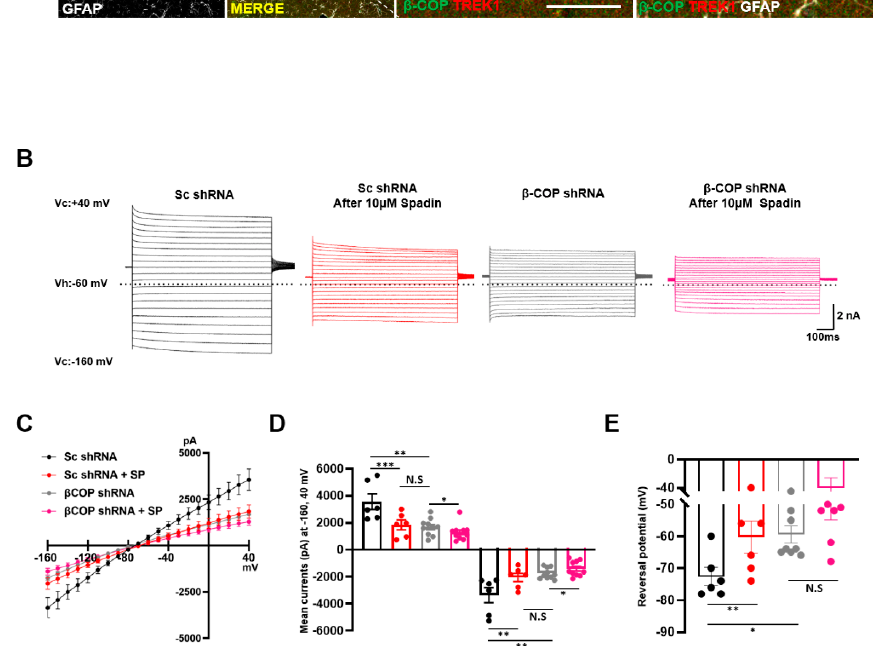
Figure 7. β -COP regulates passive conductance in hippocampal astrocytes. ( A ) Representative image of immunohistochemistry (IHC) in the hippocampus (CA1) and an enlarged image. β -COP (green) is expressed as abundantly as TREK1 (red) in GFAP-positive cells (white) of the hippocampus and colocalizes with TREK1 to a high degree (yellow). Scale bars, 50µm. ( B ) Representative traces of passive conductance induced by voltage stepping method in hippocampal astrocytes after injection with adeno-associated viruses expressing Sc shRNA or β -COP shRNA in the absence or presence of 10 µM Spadin. Voltages were stepped from − 160 mV to +40 mV in increments of 10 mV from a holding potential of − 60 mV. Dotted line indicates 0 pA. ( C ) Average current-voltage ( I-V ) relationship curves obtained from hippocampal astrocytic currents presented in ( B ). ( D ) The bar graph shows averaged current at +40 mV and − 160 mV. All values are mean ± SEM. SEM, standard error of the mean. p -values were obtained with one-way ANOVA followed by Tukey’s post hoc test. N.S: not significant, ** p < 0.01, *** p < 0.001. ( E ) Reversal potentials also obtained from average I-V curves in ( C ). All values are mean ± SEM. SEM, standard error of the mean. p -values were obtained with one-way ANOVA followed by Tukey’s post hoc test. N.S: not significant, * p < 0.05, ** p < 0.01.